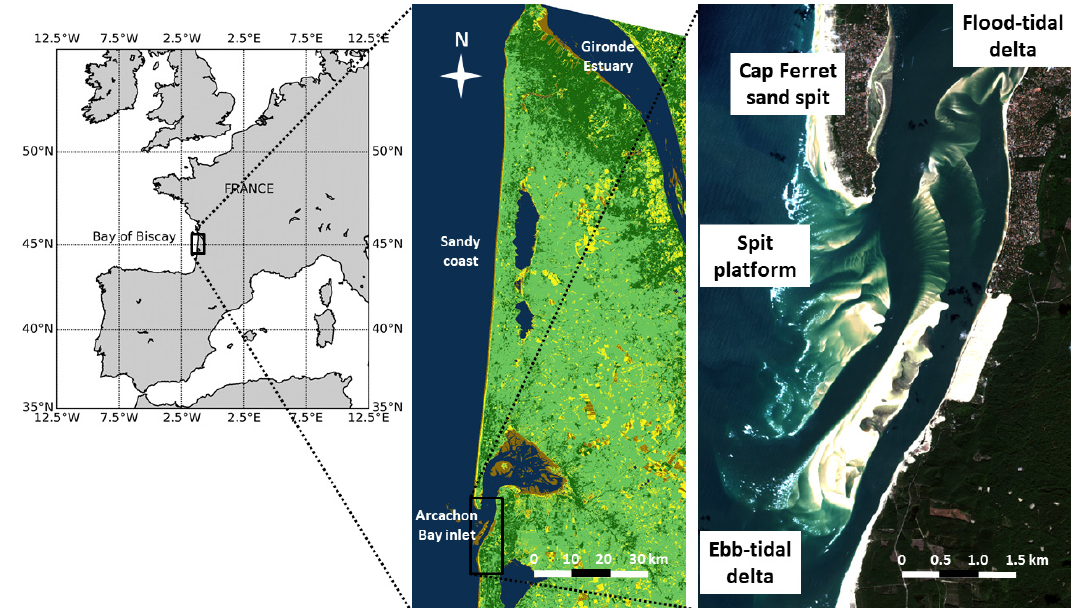
Figure 1. The Arcachon Bay inlet located south of the Gironde estuary at the end of the 110 km-long linear Gironde sandy coast (SW France). The three main morphological units of the study area are the spit platform connected to the Cap Ferret sand spit, the edd-tidal, and the flood-tidal deltas.